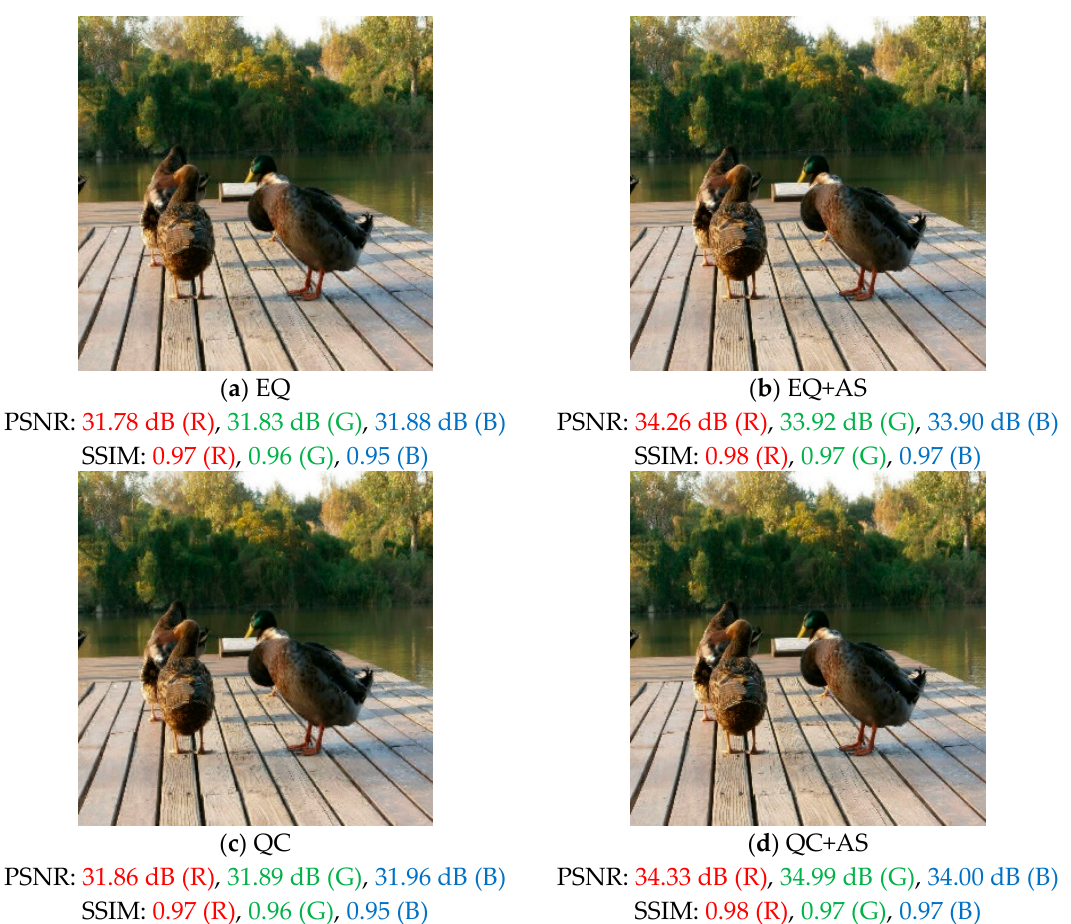
Figure 8. Reconstruction of BCS coefficients for the three color planes: ( a ) EQ only; ( b ) EQ + AS; ( c ) QC only; and ( d ) QC + AS.